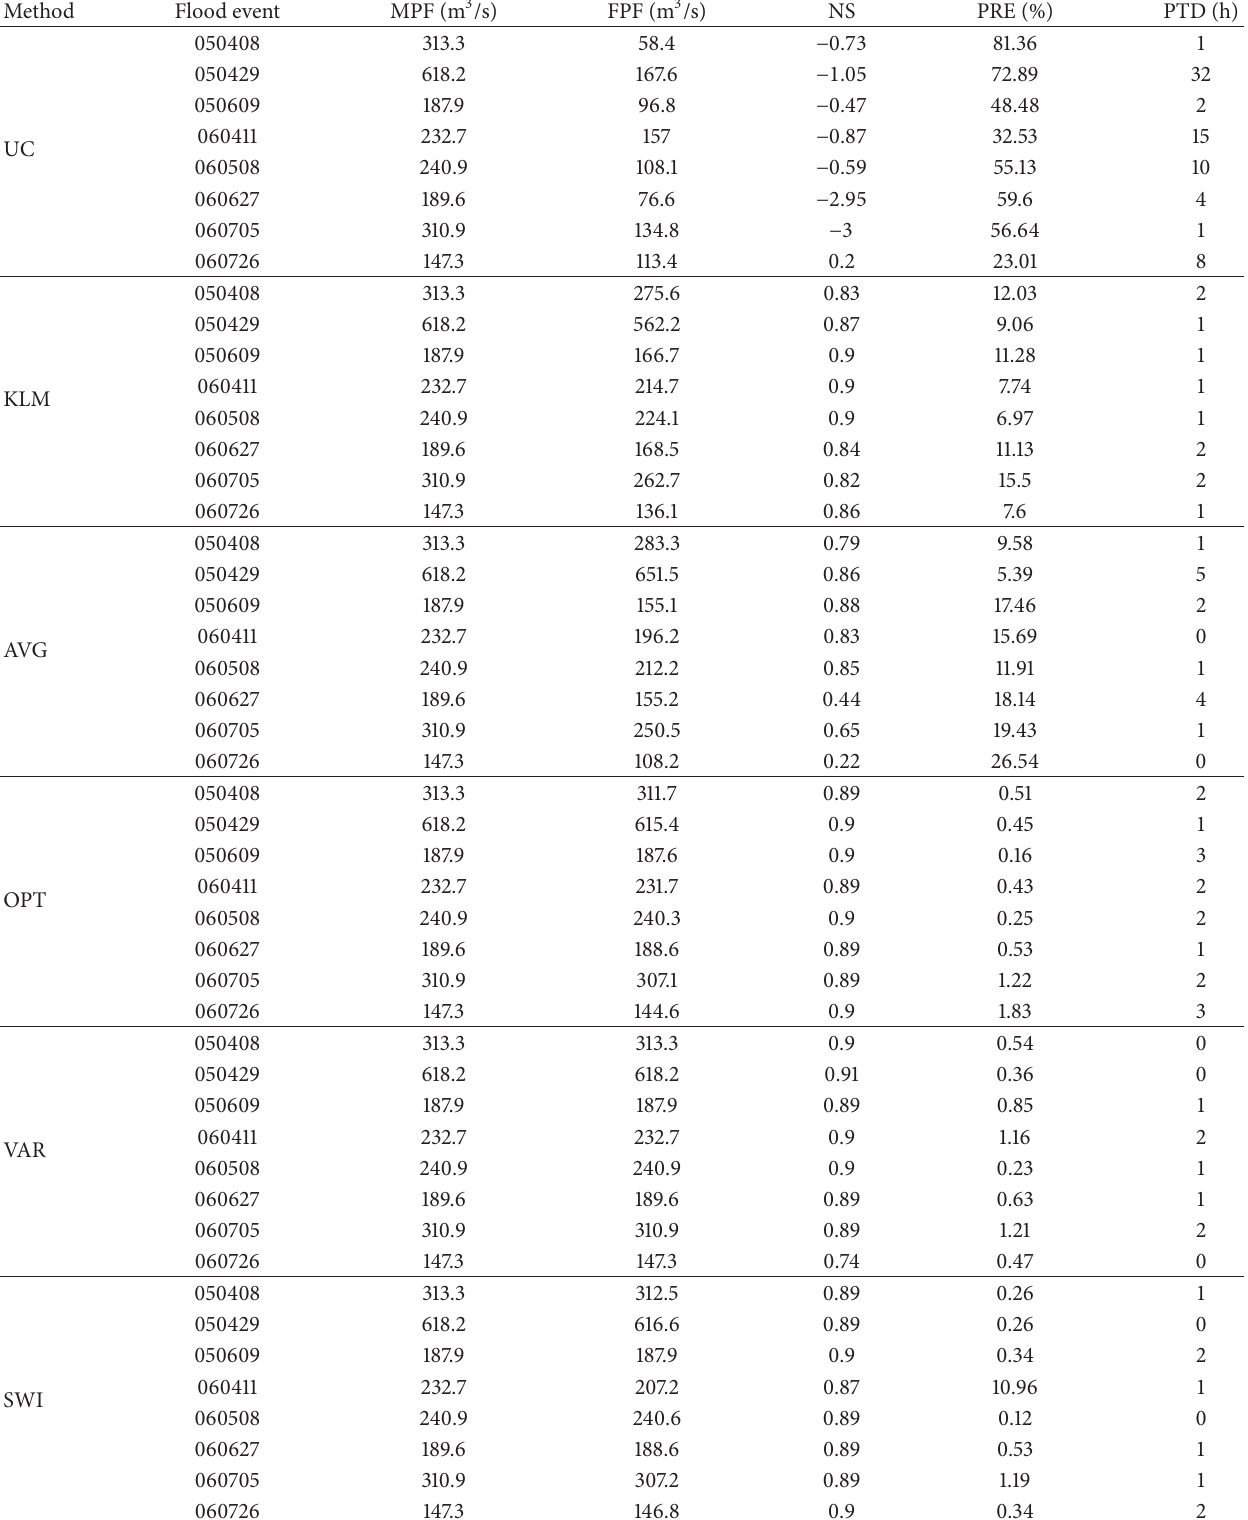
Table 3: Comparison of flood hydrograph prediction using different rainfall data assimilation methods. MPF is measured peak flow and FPF is forecast peak